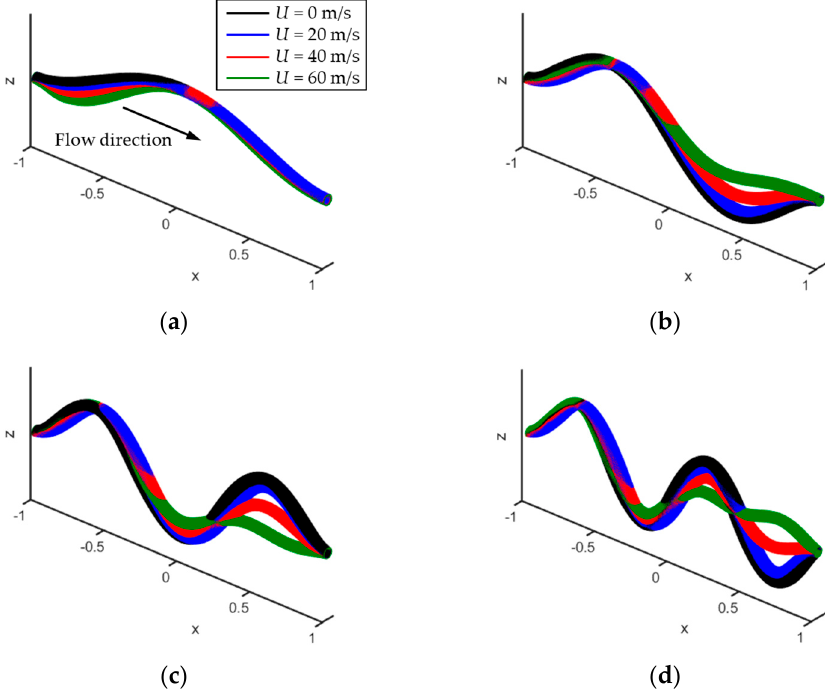
Figure 7. Numerical mode shapes of the fluid-conveying pipe when the flow velocity increased: ( a ) 1st, ( b ) 2nd, ( c ) 3rd, and ( d ) 4th mode shapes.